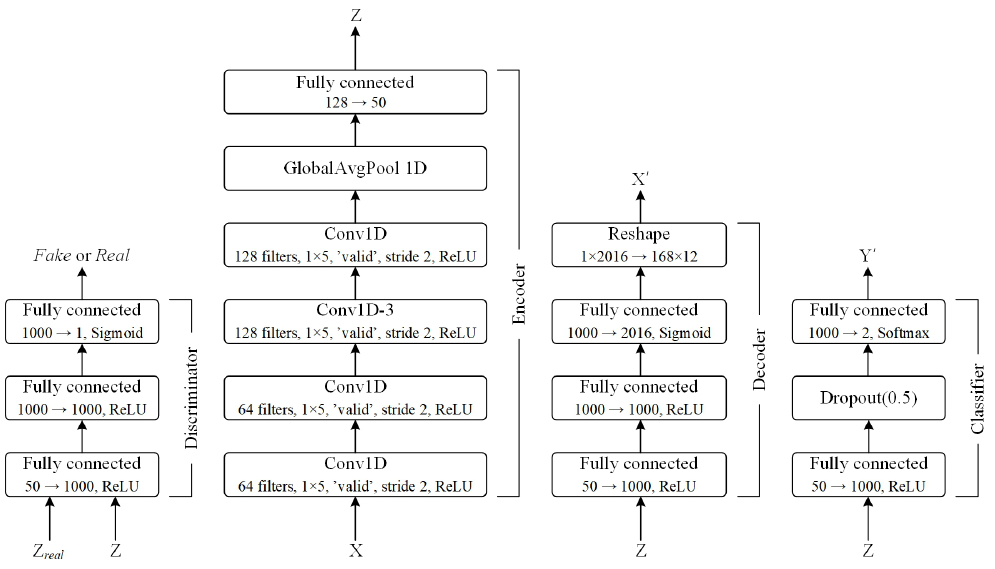
Figure 6. The detail architecture of the SSAE